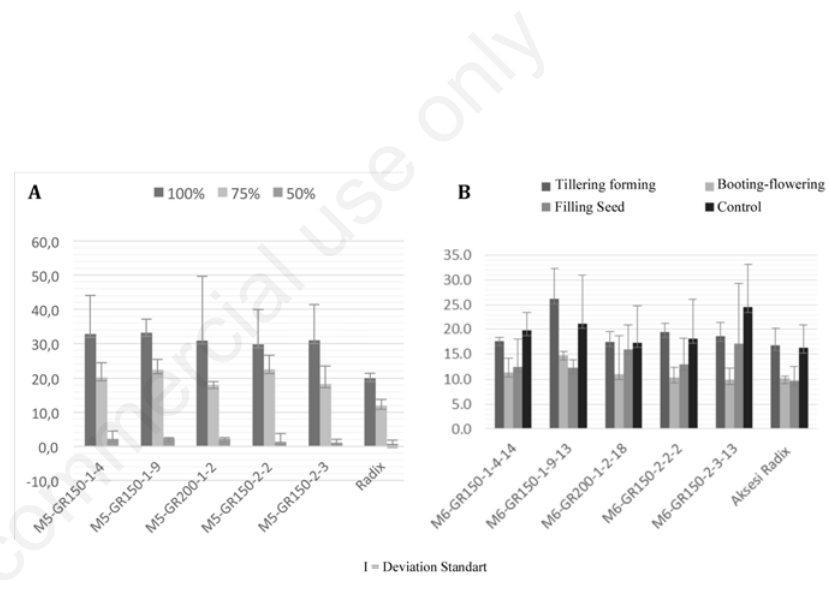
Figure 1. The mean weight of M5 filled seeds (A), M6 filled seeds (B) and radix accession to the treatment of several drought tolerance soil moisture test and drought stress in the critical period of the plant. Table 4. M5 tolerance and radix accession to the decline of 75% soil moisture. Plant traits